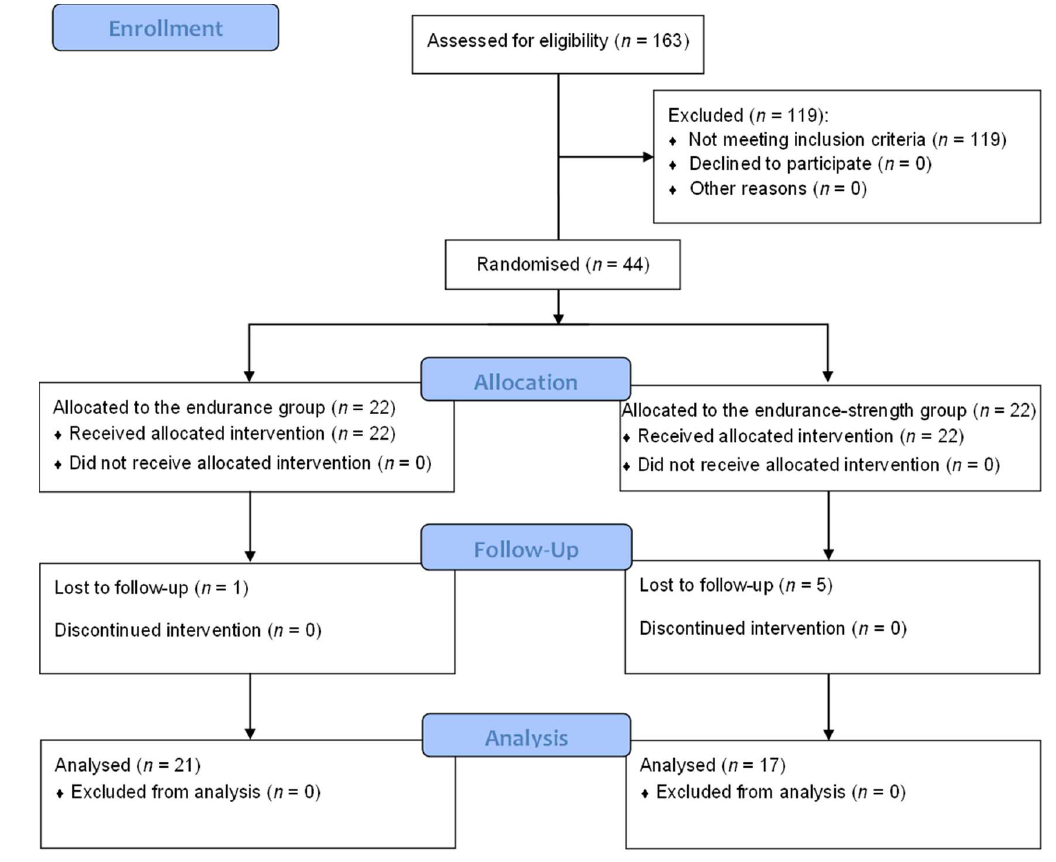
Figure 1. Study flow chart. Table 1. Baseline characteristics of the study population.